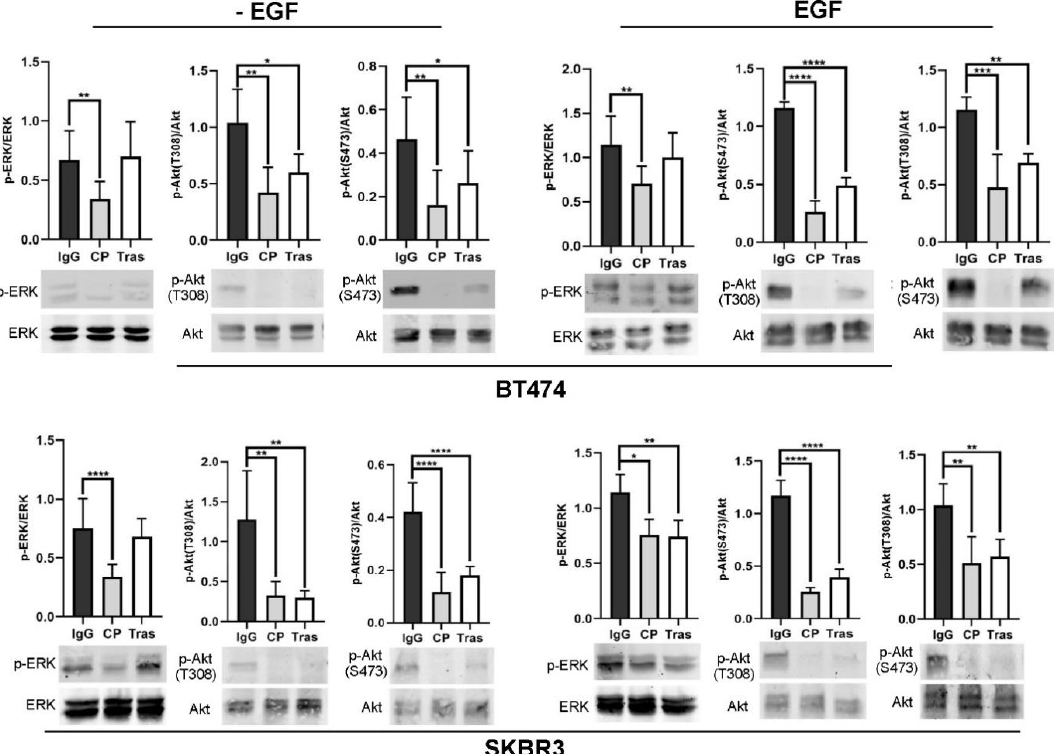
Figure 7. The effects of trastuzumab on HER2-mediated downstream signaling pathway in BT474 and SKBR3 cells. The cells were treated with trastuzumab at concentration of 10 µg/mL in the presence and absence of EGF (50 ng/mL). The phosphorylation of Akt at threonine (T) 308 and serine (S) 473 phosphorylation sites as well as Erk phosphorylation were revealed by immunoblotting. Cells treated with normal human IgG were used as negative control and cells treated with CP – 714724 (CP) at 1 µM were used as positive control. Each value is the average of at least three experiments and the error bar is standard error. *: p < 0.05, **: p < 0.01, ***: p < 0.001, ****: p < 0.0001.